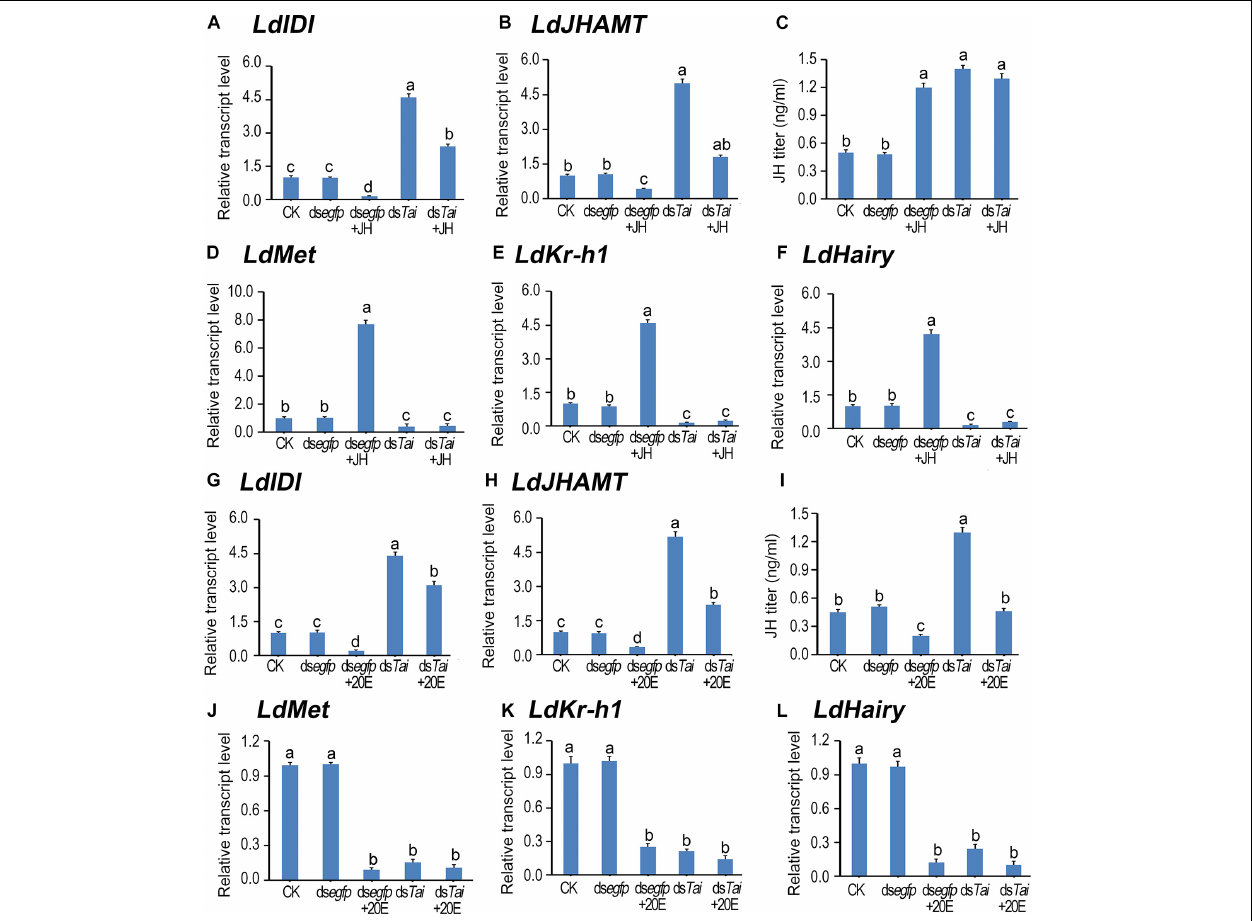
FIGURE 4 | Deletion of LdTai disturbs JH signal in Leptinotarsa decemlineata . The newly ecdysed final instar larvae had ingested PBS (CK)-, ds egfp -, JH-, ds Tai - and ds Tai +JH-dipped leaves, or PBS (CK)-, ds egfp -, 20E-, ds Tai - and ds Tai +20E-immersed foliage for 3 days. The expression levels of two JH biosynthesis genes LdIDI (A,G) and LdJHAMT (B,H) , three JH signaling genes LdMet (D,J) , LdKr-h1 (E,K) and LdHairy (F,L) were measured using qRT-PCR. JH titer was tested (C,I) . The bars represent average values ( ± SE). Different letters indicate significant difference at P -value <